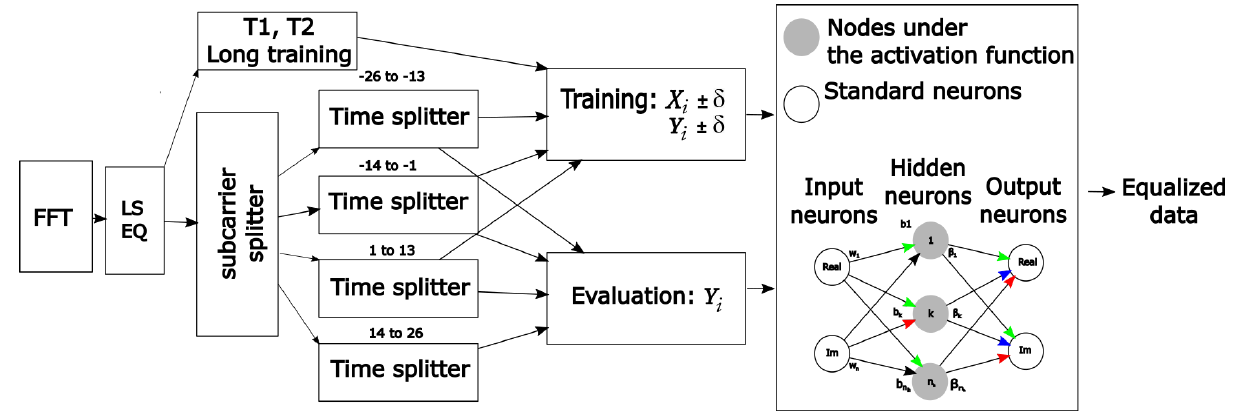
Figure 7. Block diagram of the equalization